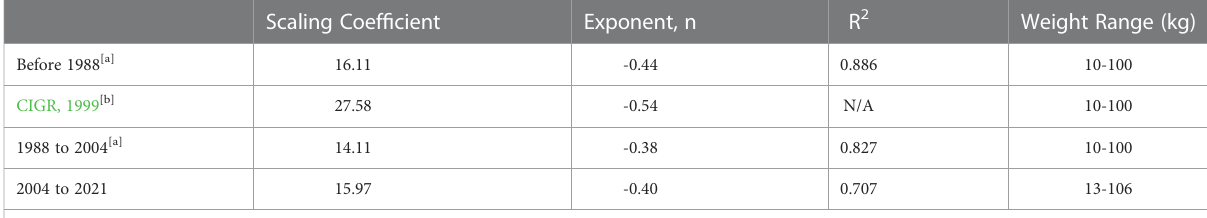
TABLE 1 Comparison of power regression coef fi cients for heat